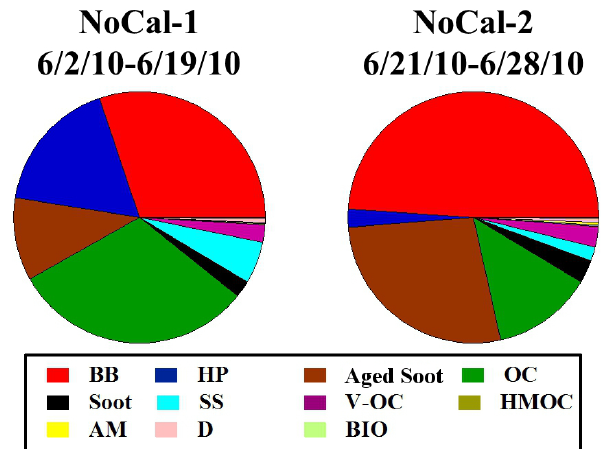
Fig. 8. Number fractions of A-ATOFMS particle types for two pe- riods in the CARES campaign, NoCal-1 and